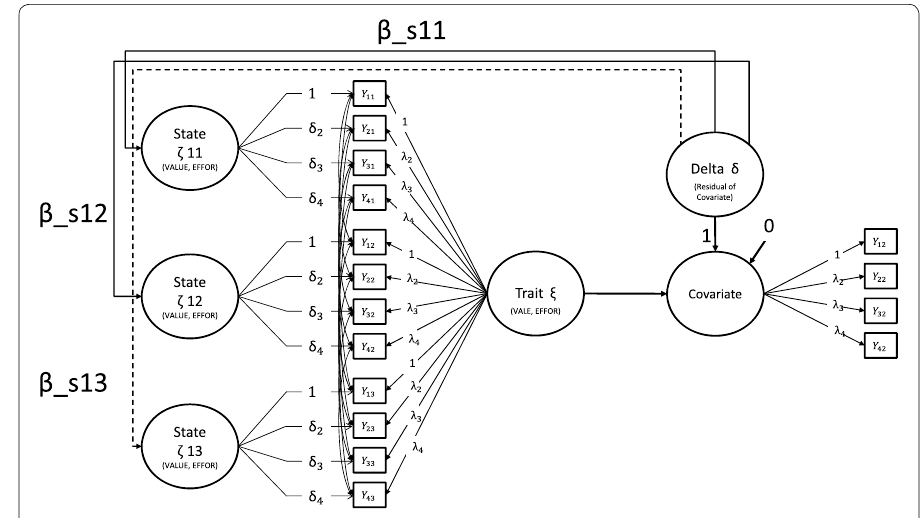
Fig. 4 Bifactor model using the residual approach to predict the state factors. VALUE Subjective test value = dimension of the test motivation construct. EFFOR Effort dimension of the test motivation construct. = 11, 12, 13 grade 11, grade 12, grade 13. The association β_ s13 (states at grade 13) is depicted as dashed = line indicating that this association is not investigated in the present study. β _s11 (states at grade 11) and β _s12 (states at grade 12) indicate the associations of interest. The correlated uniqueness approach (item/ method-specific correlations over time) is indicated by vertical curved (unlabelled)